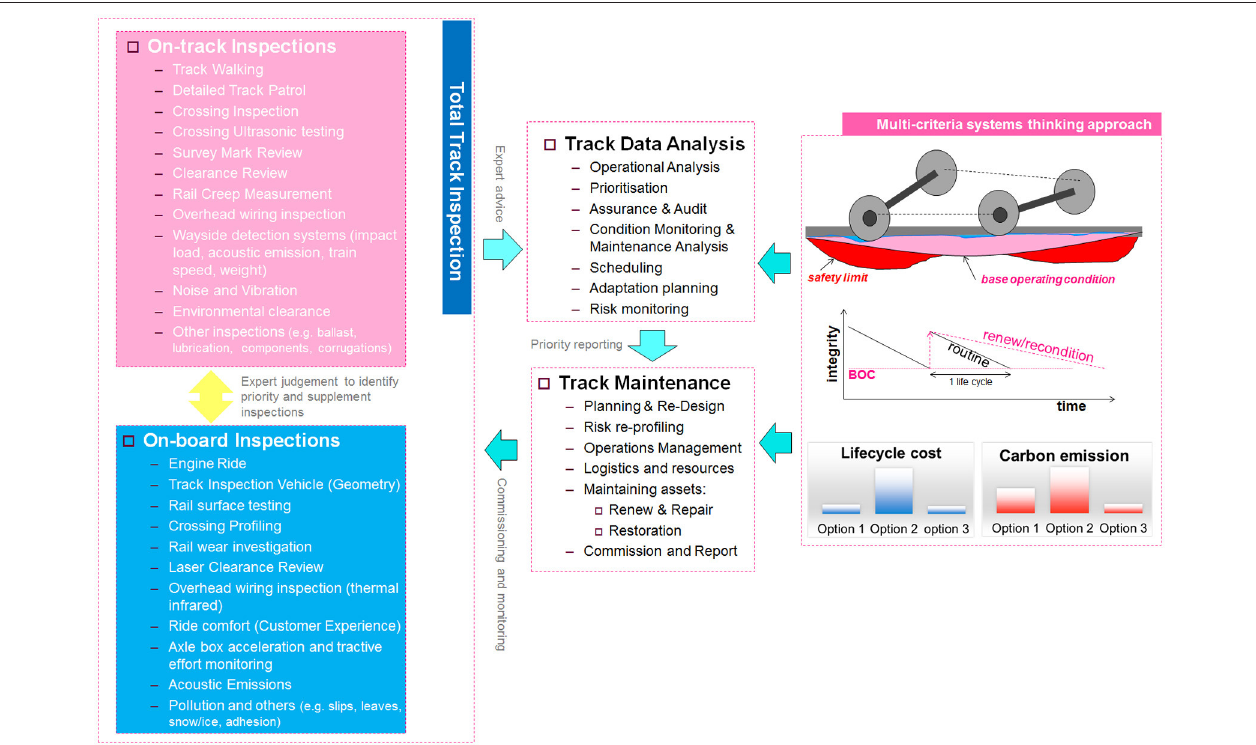
FIGURE 1 | Total track